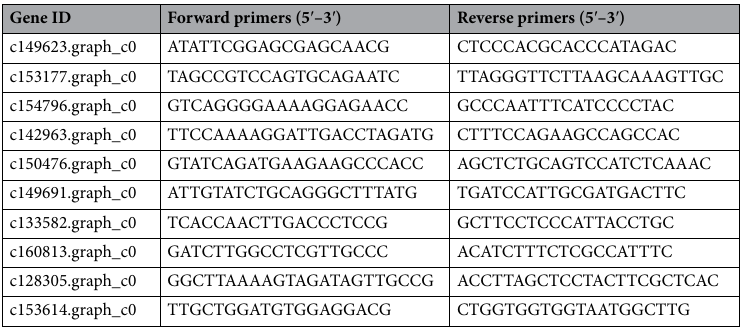
Table 4. The primers used for real-time